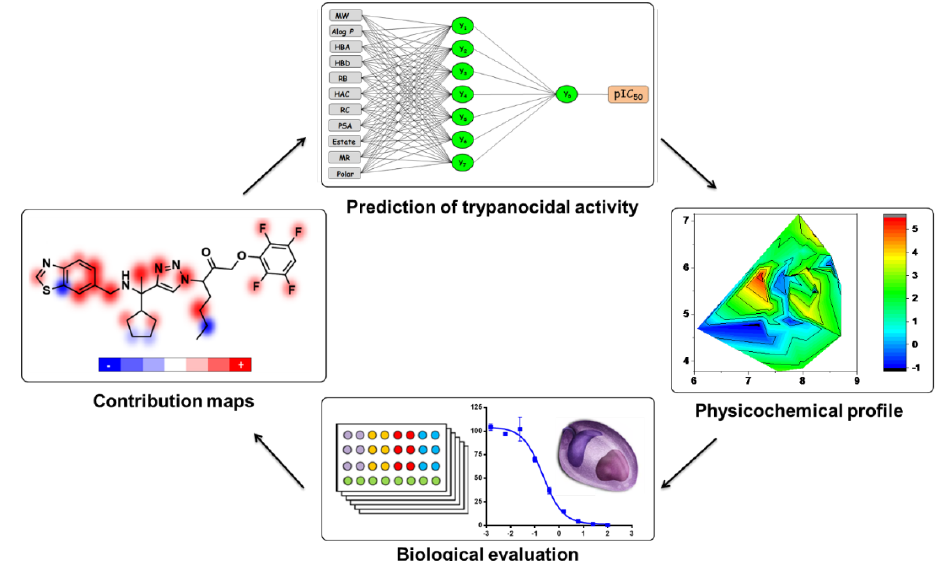
Figure 12. Proposed workflow for the design of novel anti- Trypanosoma cruzi compounds based on the generation of contribution maps, prediction of trypanocidal activity using artificial neural networks, and analysis of physicochemical properties. Compounds featuring favorable properties can be synthesized and evaluated against the parasite.